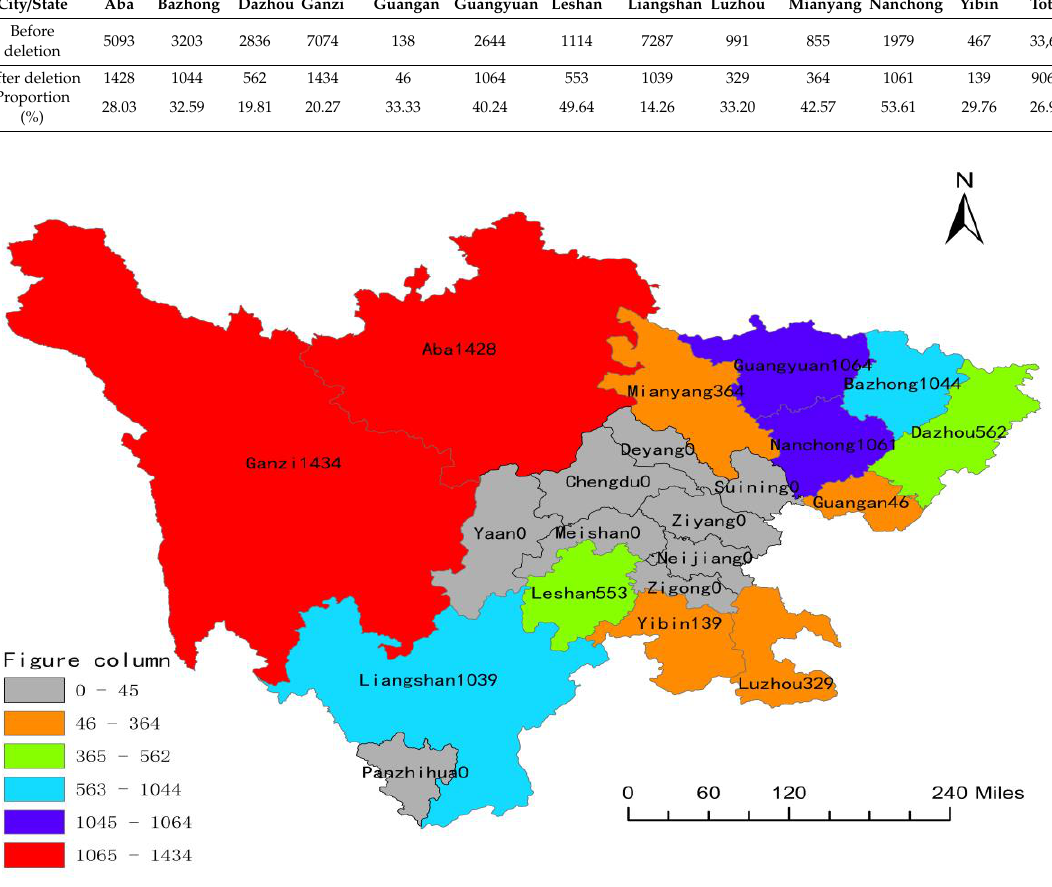
Figure 3. Distribution of data samples in Sichuan province.